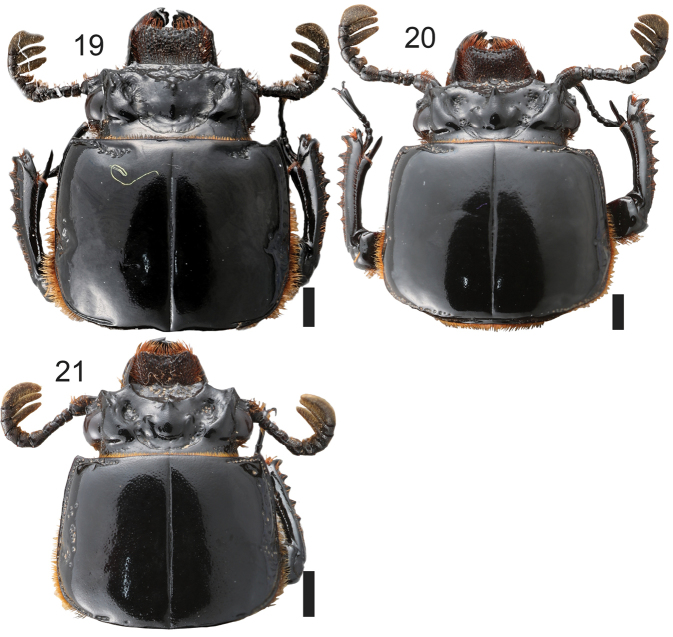
Head and pronotum: 19Passalus
convexus20Passalus
interruptus21Passalus
punctiger. Scale bars: 2 mm.